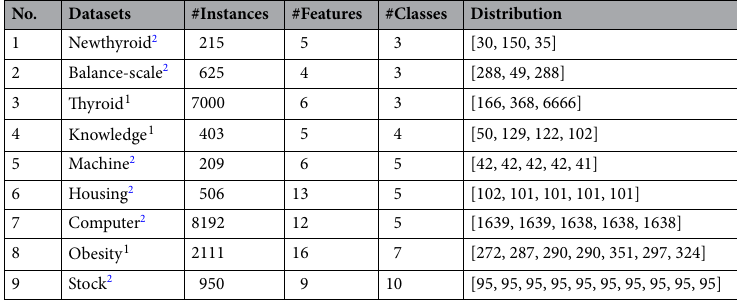
Table 1. Information of the used datasets. https:// archi ve. ics. uci. edu/ ml/ index.